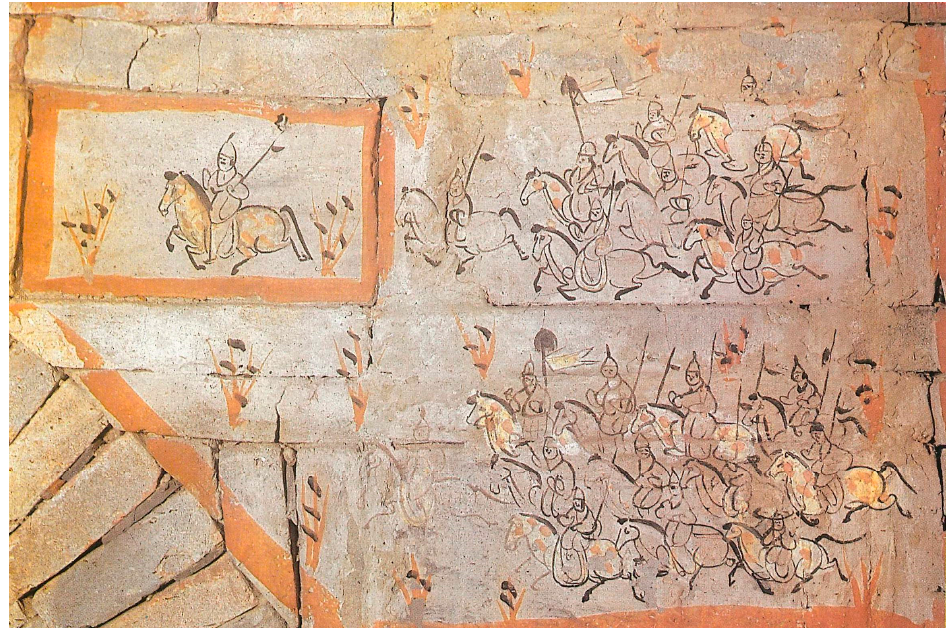
Figure 8. Military campaign, north wall of front chamber, Xincheng M3, painted brick, Wei-Jin pe- Figure8. Militarycampaign, northwalloffrontchamber, Xincheng M3, paintedbrick, Wei‑Jinperiod riod (220–317). (Gansusheng Bowuguan et al. 1985, color pl. 2.1). (220–317). (Gansusheng Bowuguan et al. 1985, color pl. 2.1). ©Wenwu Press. This figure published with permission of Wenwu Press and cannot be used or copied without their